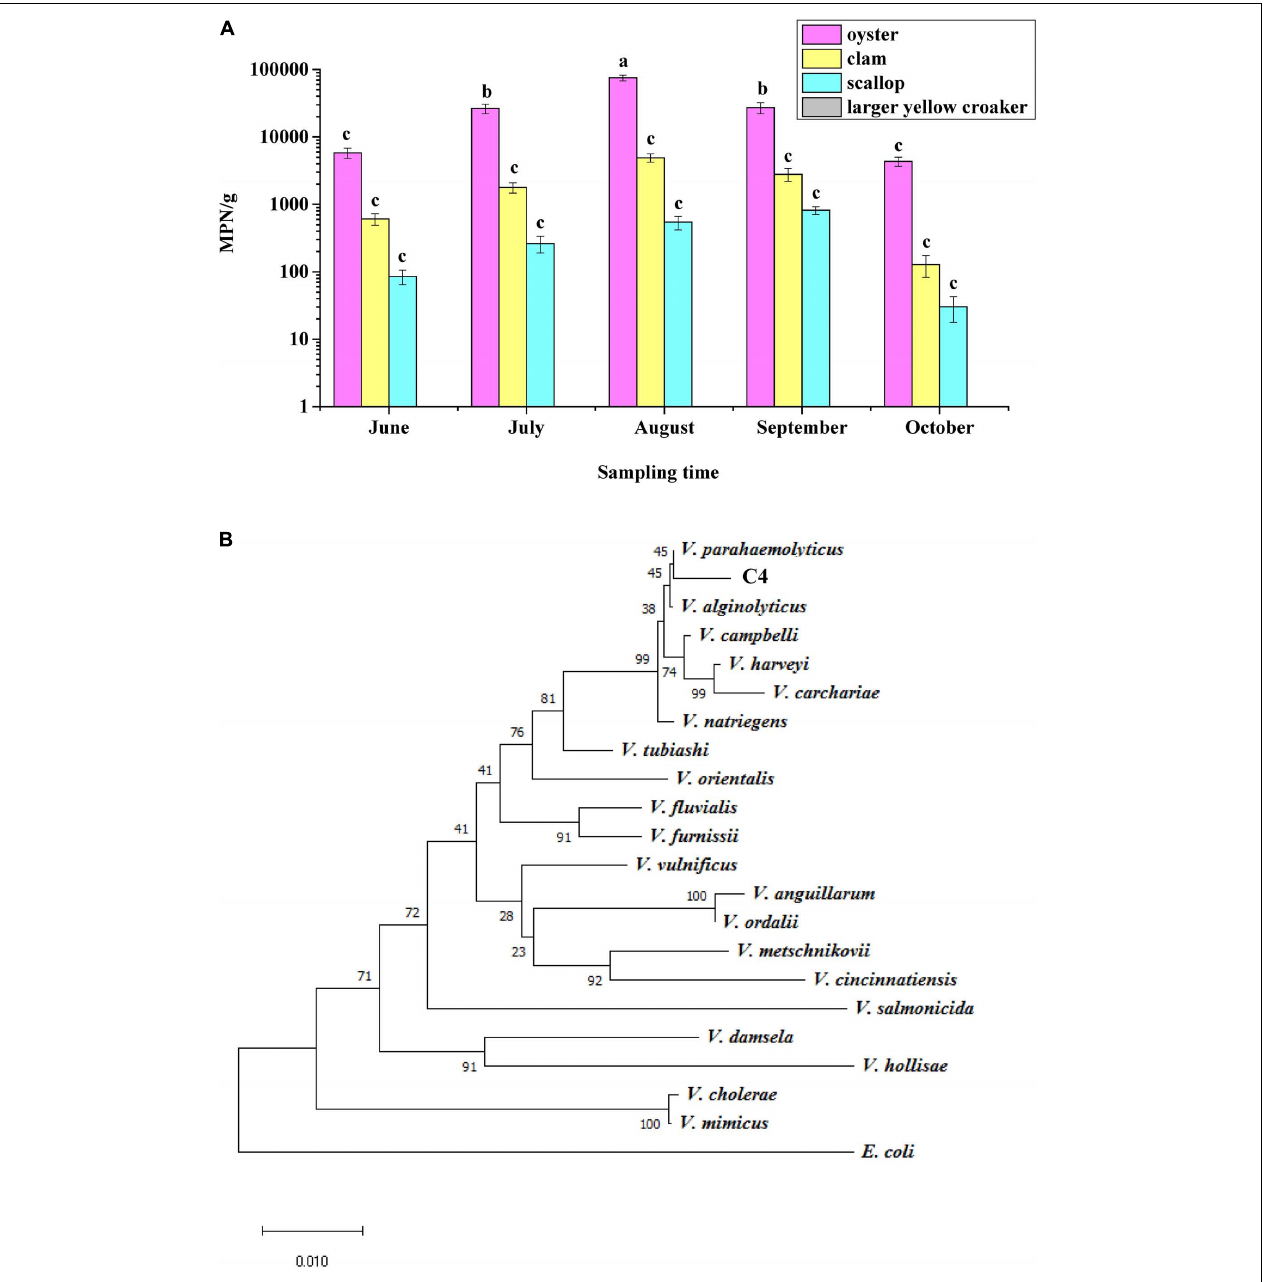
FIGURE 1 | Identification of Vibrio parahaemolyticus . (A) Analysis of the status of V. parahaemolyticus contamination in four kinds of seafood. (B) Phylogenetic tree based on 16S rRNA gene sequences showing that the C4 strain represents a subgroup within the genus V. parahaemolyticus